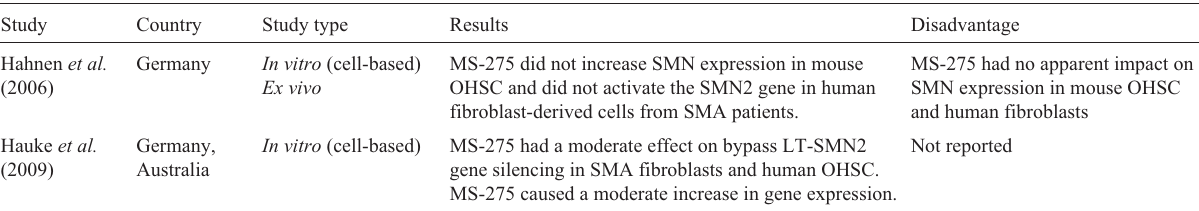
Table 8 - Summary of studies on MS-275 for the treatment of spinal muscular atrophy.